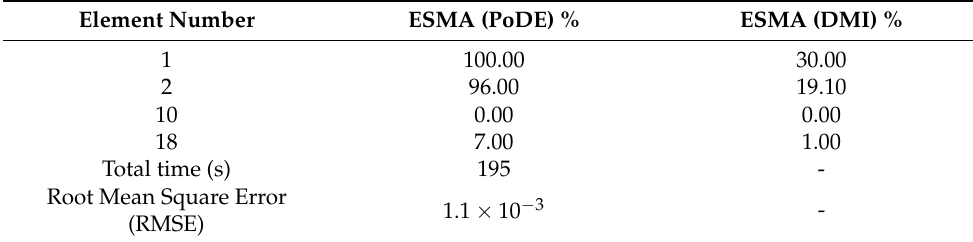
Table 4. PoDEs and DMIs of case 2 for the 31-bar planar truss.